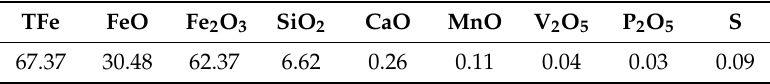
Table 2. The main composition of magnetite